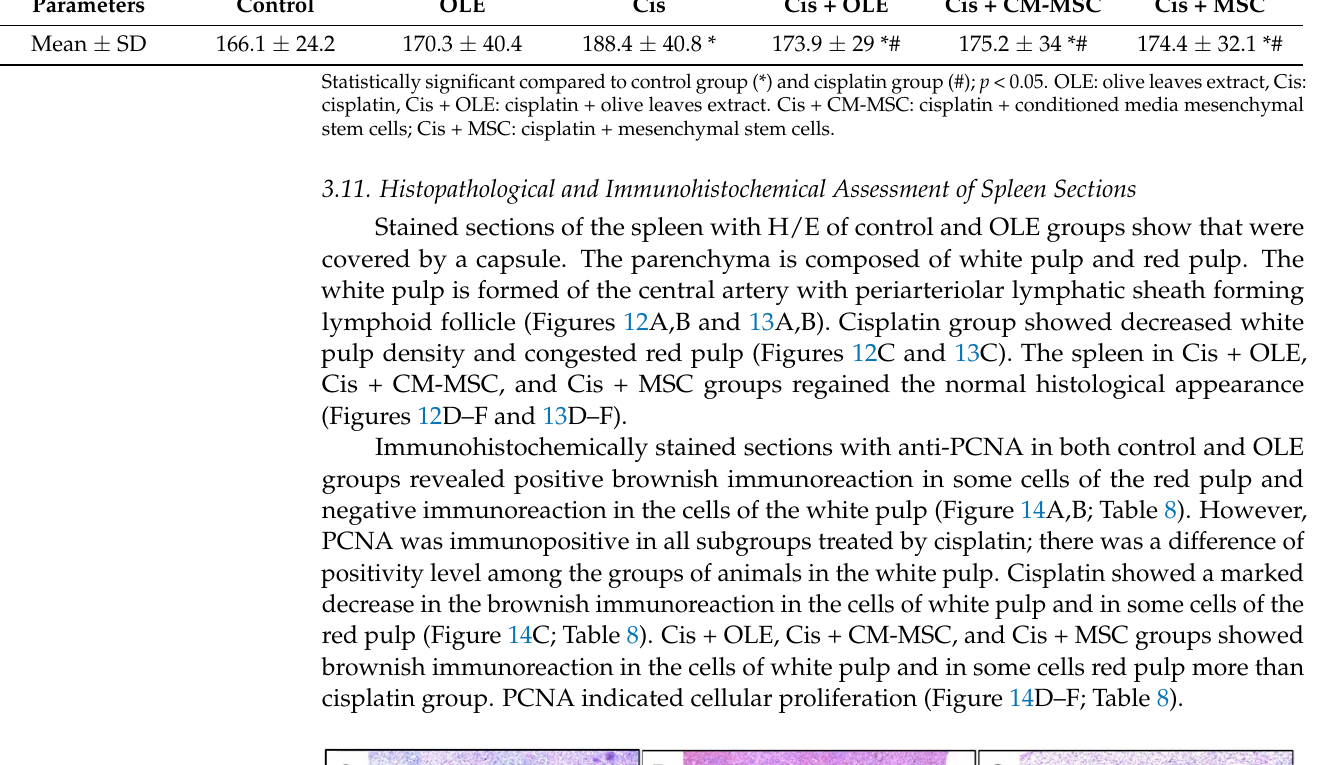
Figure 13. Photomicrographs of section of the spleen stained with H/E ×400 from different groups. ( A ): (Control group) shows capsule (C), white pulp (WP), and red pulp (RP). The white pulp is formed of central artery (CA), periarteriolar lymphatic sheath (PALS), lymphoid follicle (LF), and marginal zone (MZ). ( B ): (OLE group) is similar to control group. ( C ): (Cis group) shows small white pulp density and congested red pulp. ( D ): (Cis + OLE group) shows small white pulp density and congested red pulp, but better than cisplatin group. ( E ): (Cis + CM-MSC group) shows small white